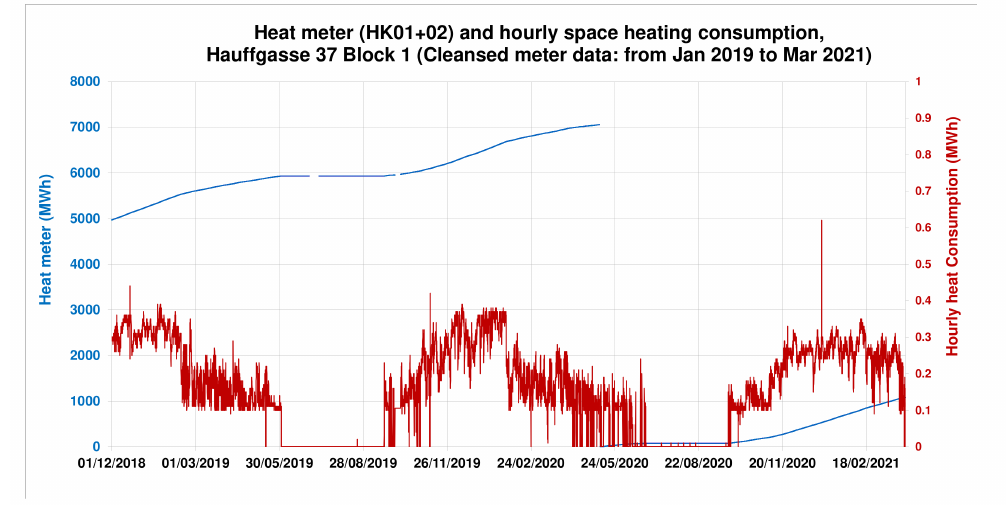
Figure 9. Monitoring data from the space-heating consumption meter for the accumulated meter data and the hourly heat consumption, Hauffgasse, Vienna.